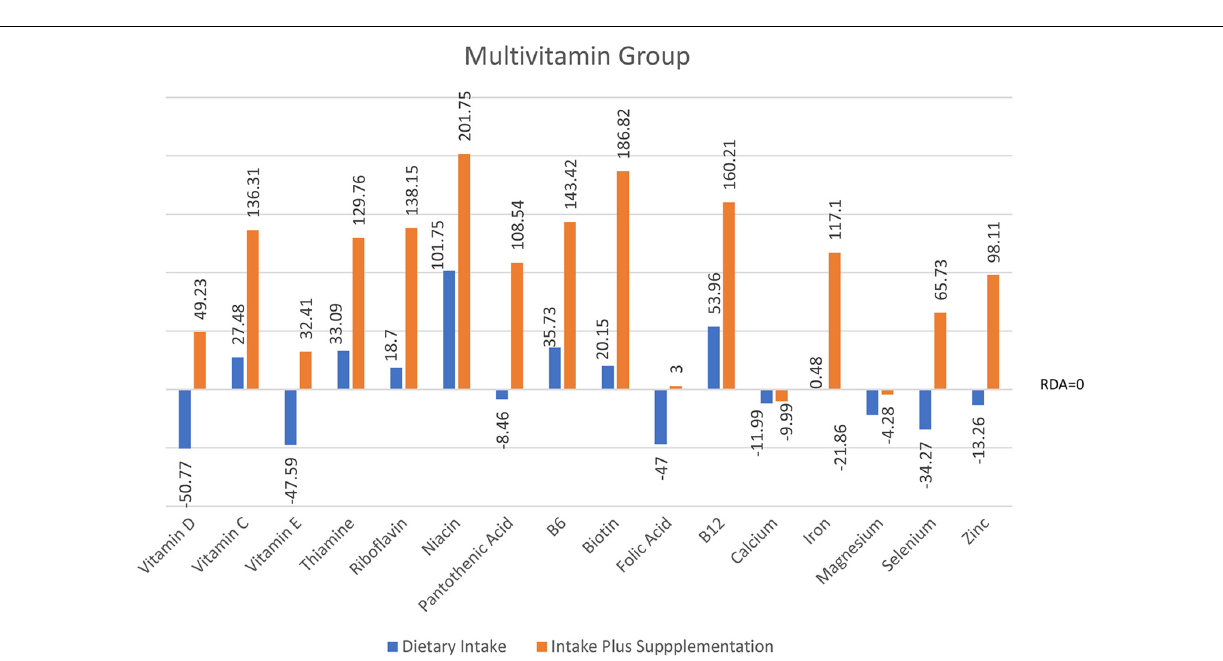
improvements in visual strategy generation (Design